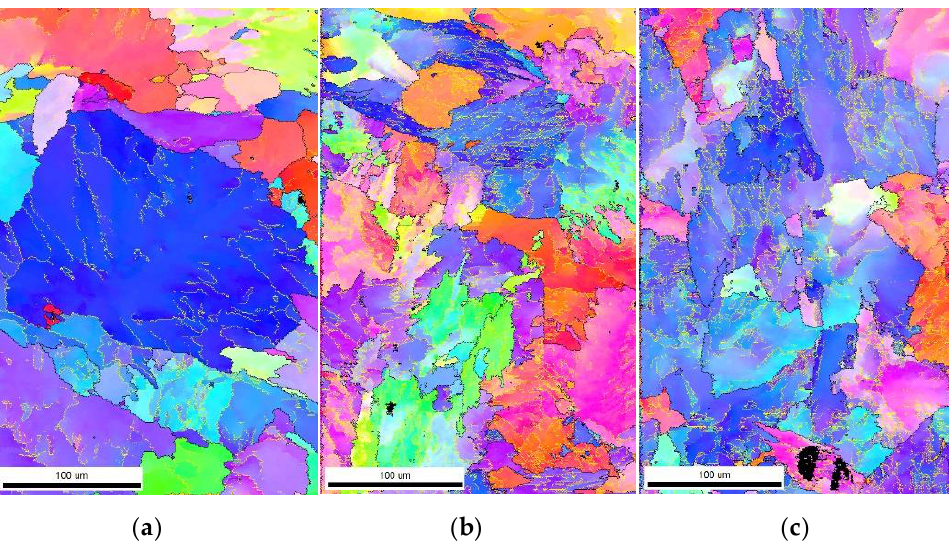
Figure 2. Electron backscatter diffraction (EBSD) inverse pole figure maps of the alloys for creep tests: ( a ) 0.03 Hf alloy, ( b ) 0.09 Hf alloy, ( c ) 0.33 Hf alloy. The orientations are indexed by α-ferrite (body-centered cubic structure). Black lines denote boundary level above 15° and yellow lines, boundary level between 2° and 15°.